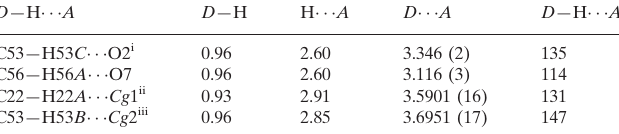
Hydrogen-bond geometry (A˚ , (cid:3)